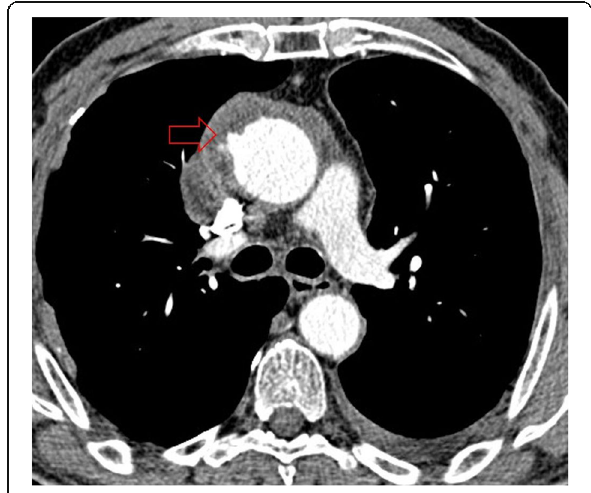
Fig. 18 Axial chest CT image in the mediastinal window shows pseudoaneurysm formation and wall erosion in ascending aorta (red